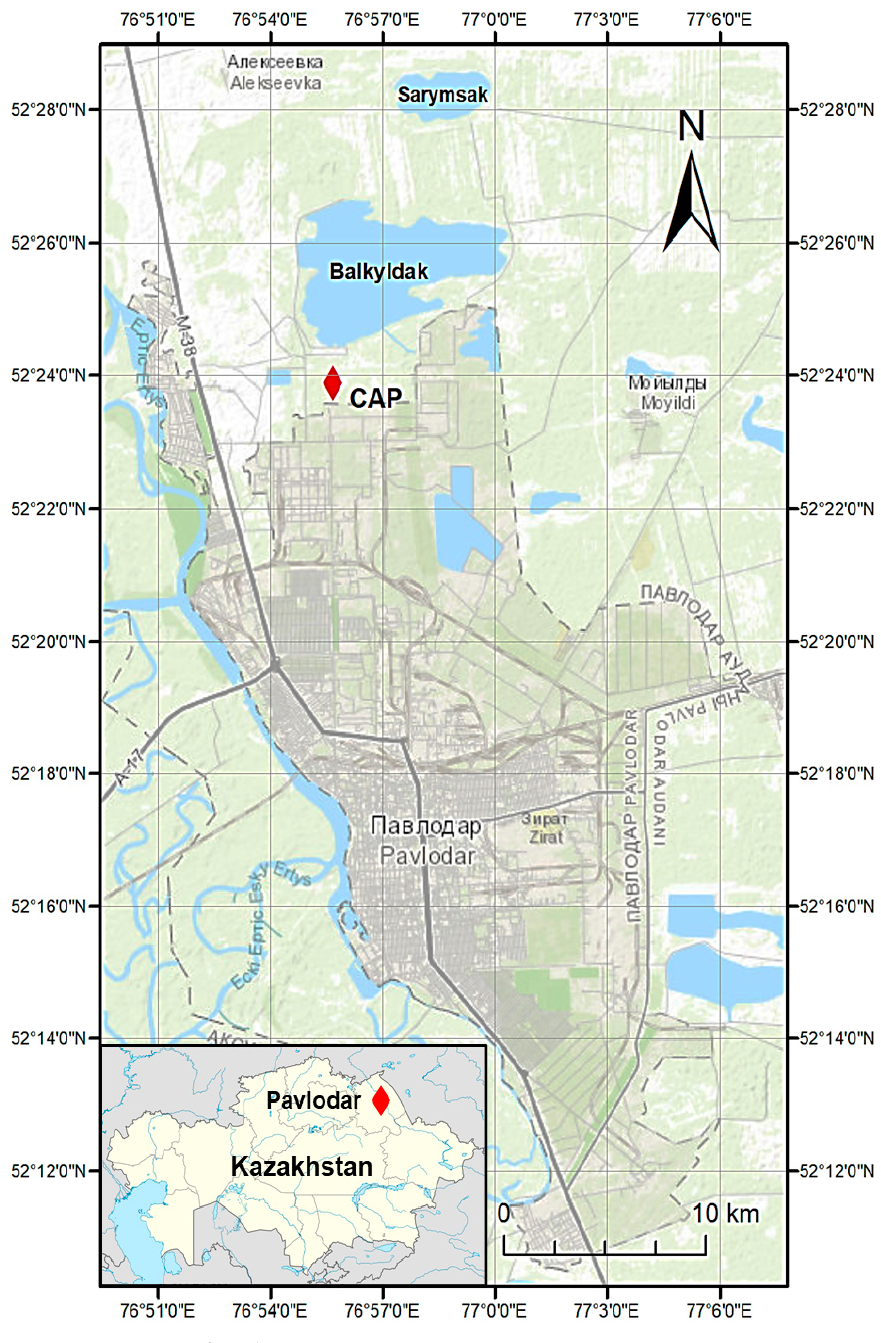
Figure 1. Location of study